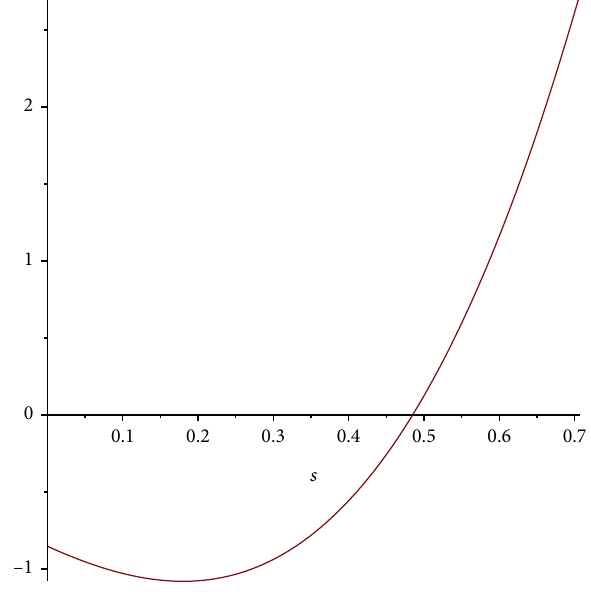
ð s Þ for s ∈ ð 0, 1/ 1 ffiffiffi p (cid:2) , respectively. Therefore, ð q 2